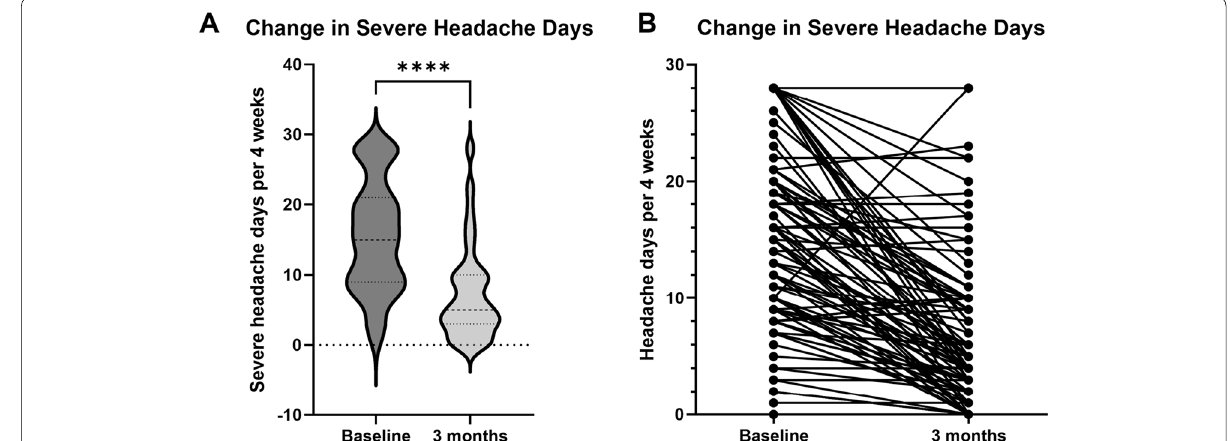
Fig. 2 violin plot (a) and before-after individual values plot (b) showing severe headache days at 3 months compared to baseline. There was a significant reduction in severe headache days. In (a) dashed line shows median, dotted lines at upper and lower quartiles. **** p < 0.0001 by